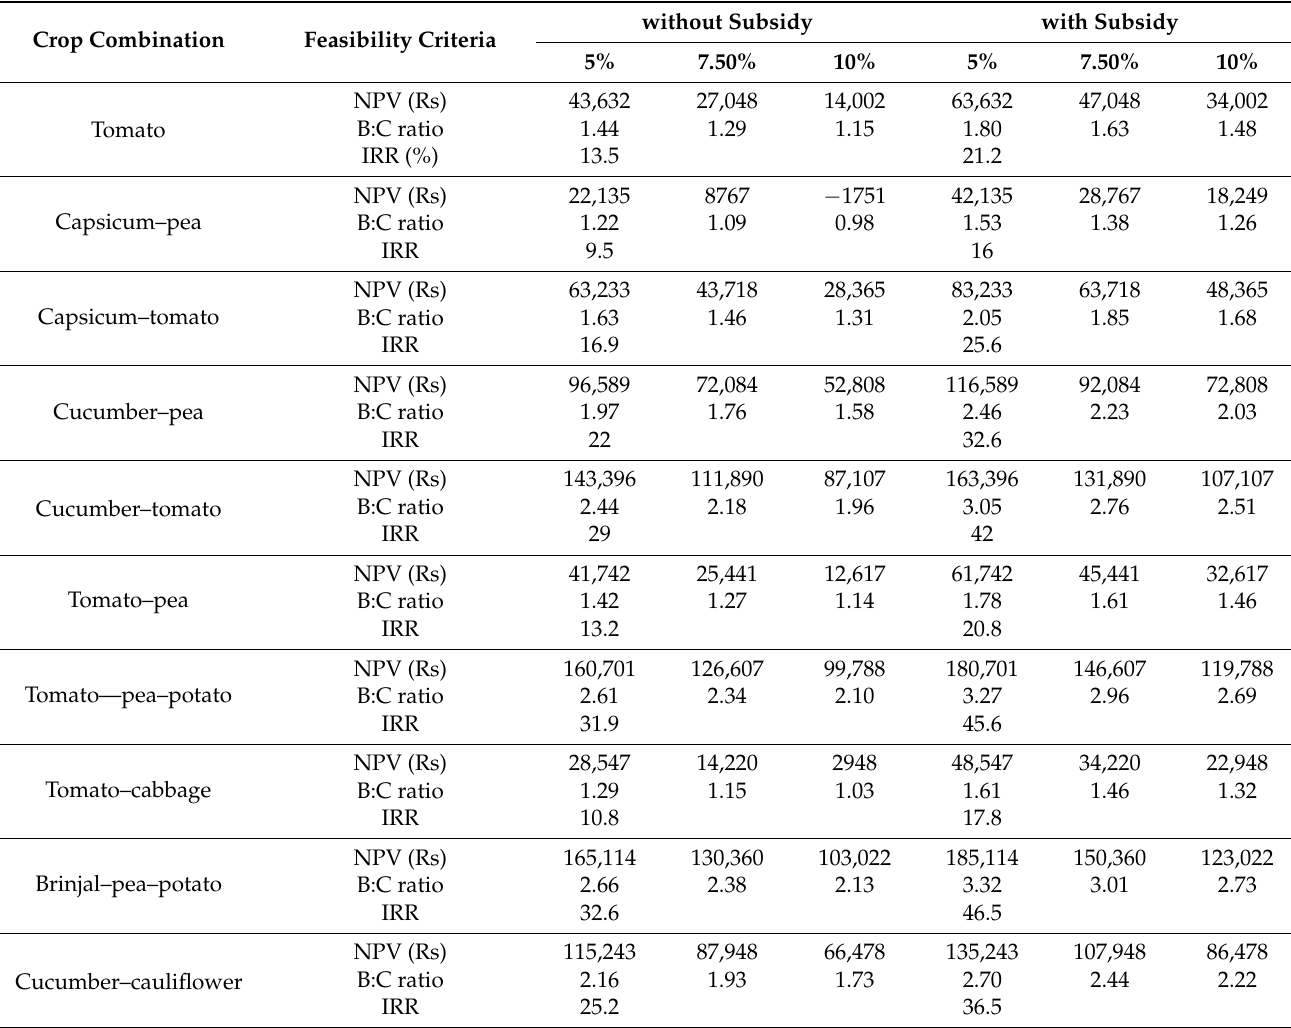
Table 13. Feasibility analysis of protected cultivation of vegetables under wood-based polyhouse in Almora district of